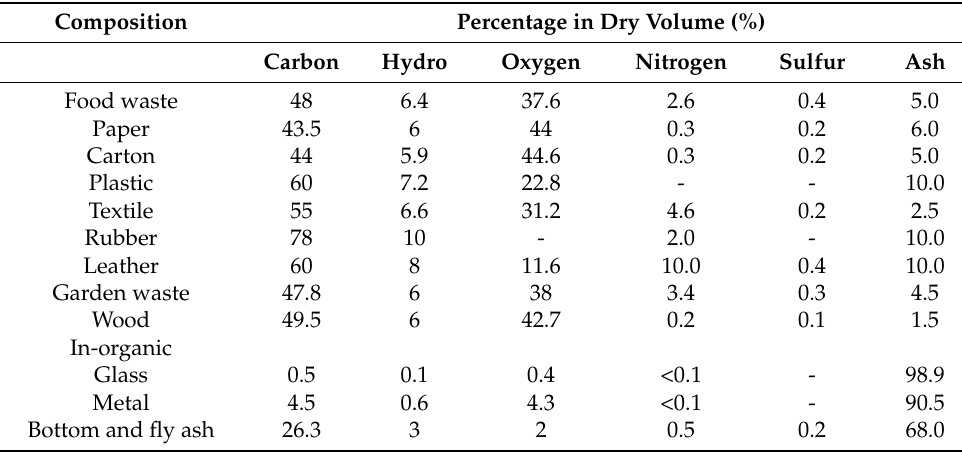
Table 7. Combustible substances in HSW in Vietnam. Source: Dieu. T.M. Tran [25].